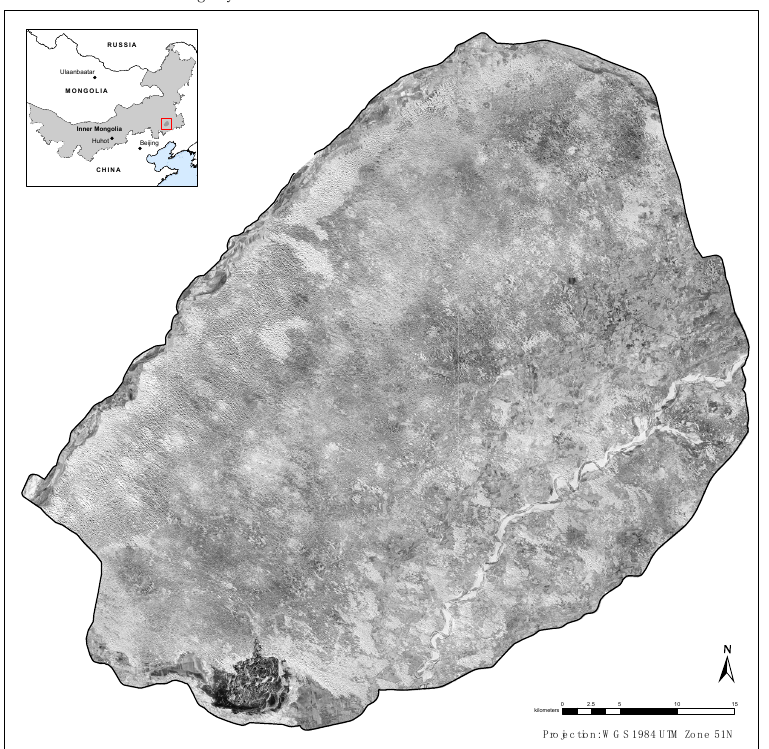
Figure 7. Final mosaic of central Naiman Banner, Inner Mongolia in 1970 derived from Corona imagery. Red box in inset map shows approximate location of the study area.